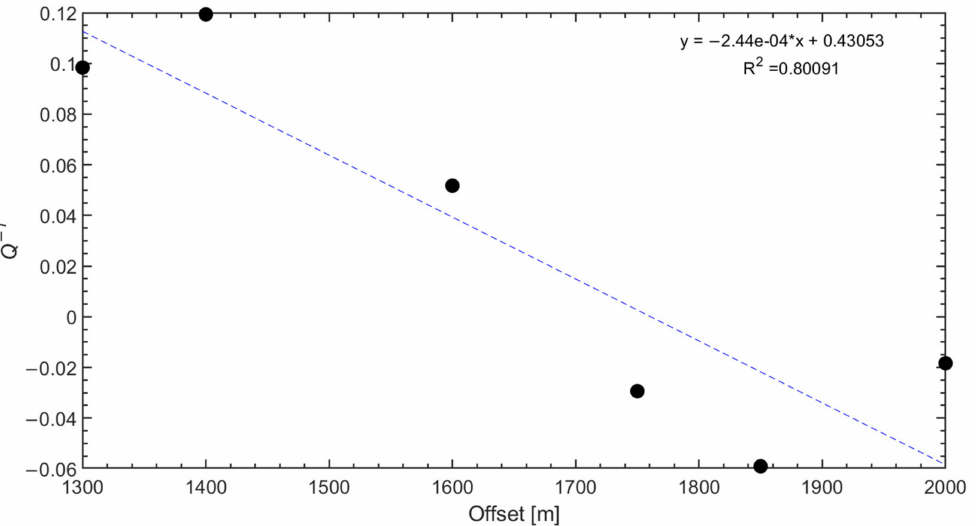
Figure 9. Variation of attenuation Q − 1 with offset. Q − 1 was estimated from hydrophones with minimum offsets at the receiver lines as shown in Figure 5. Blue dashed line is the best-fit linear regression line. R 2 is the determination coefficient. R 2 = 1 − calculated from the equation of the linear regression y = − 2.44 × 10 − 4 x + 0.43053, Q − 1 attenuation estimated from the 3D OBC seismic data, and N (=6) is the number of